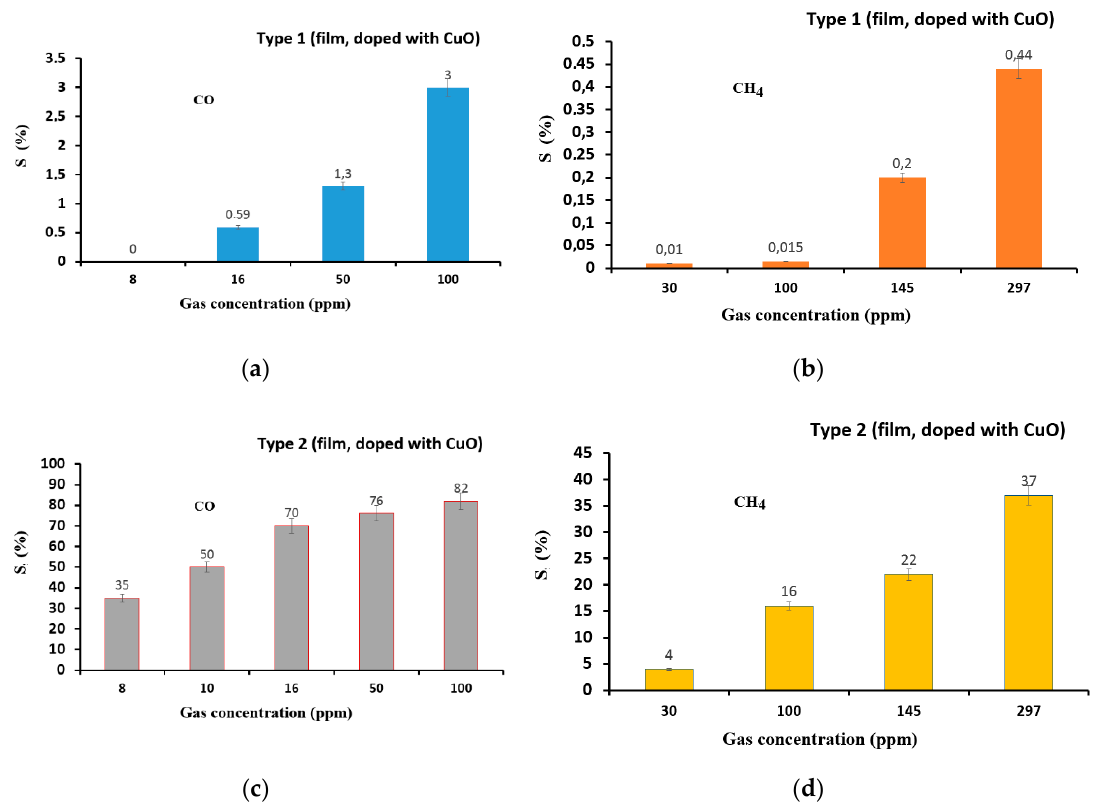
Figure 9. Relationship between the response and CO ( a , d ) and CH 4 ( c , d ) concentration for type-1 (film, doped with CuO) ( a , b ) and type-2 (film, doped with CuO) ( c , d )) gas sensor at 200°C (type-1) and 250 °C (type-2).